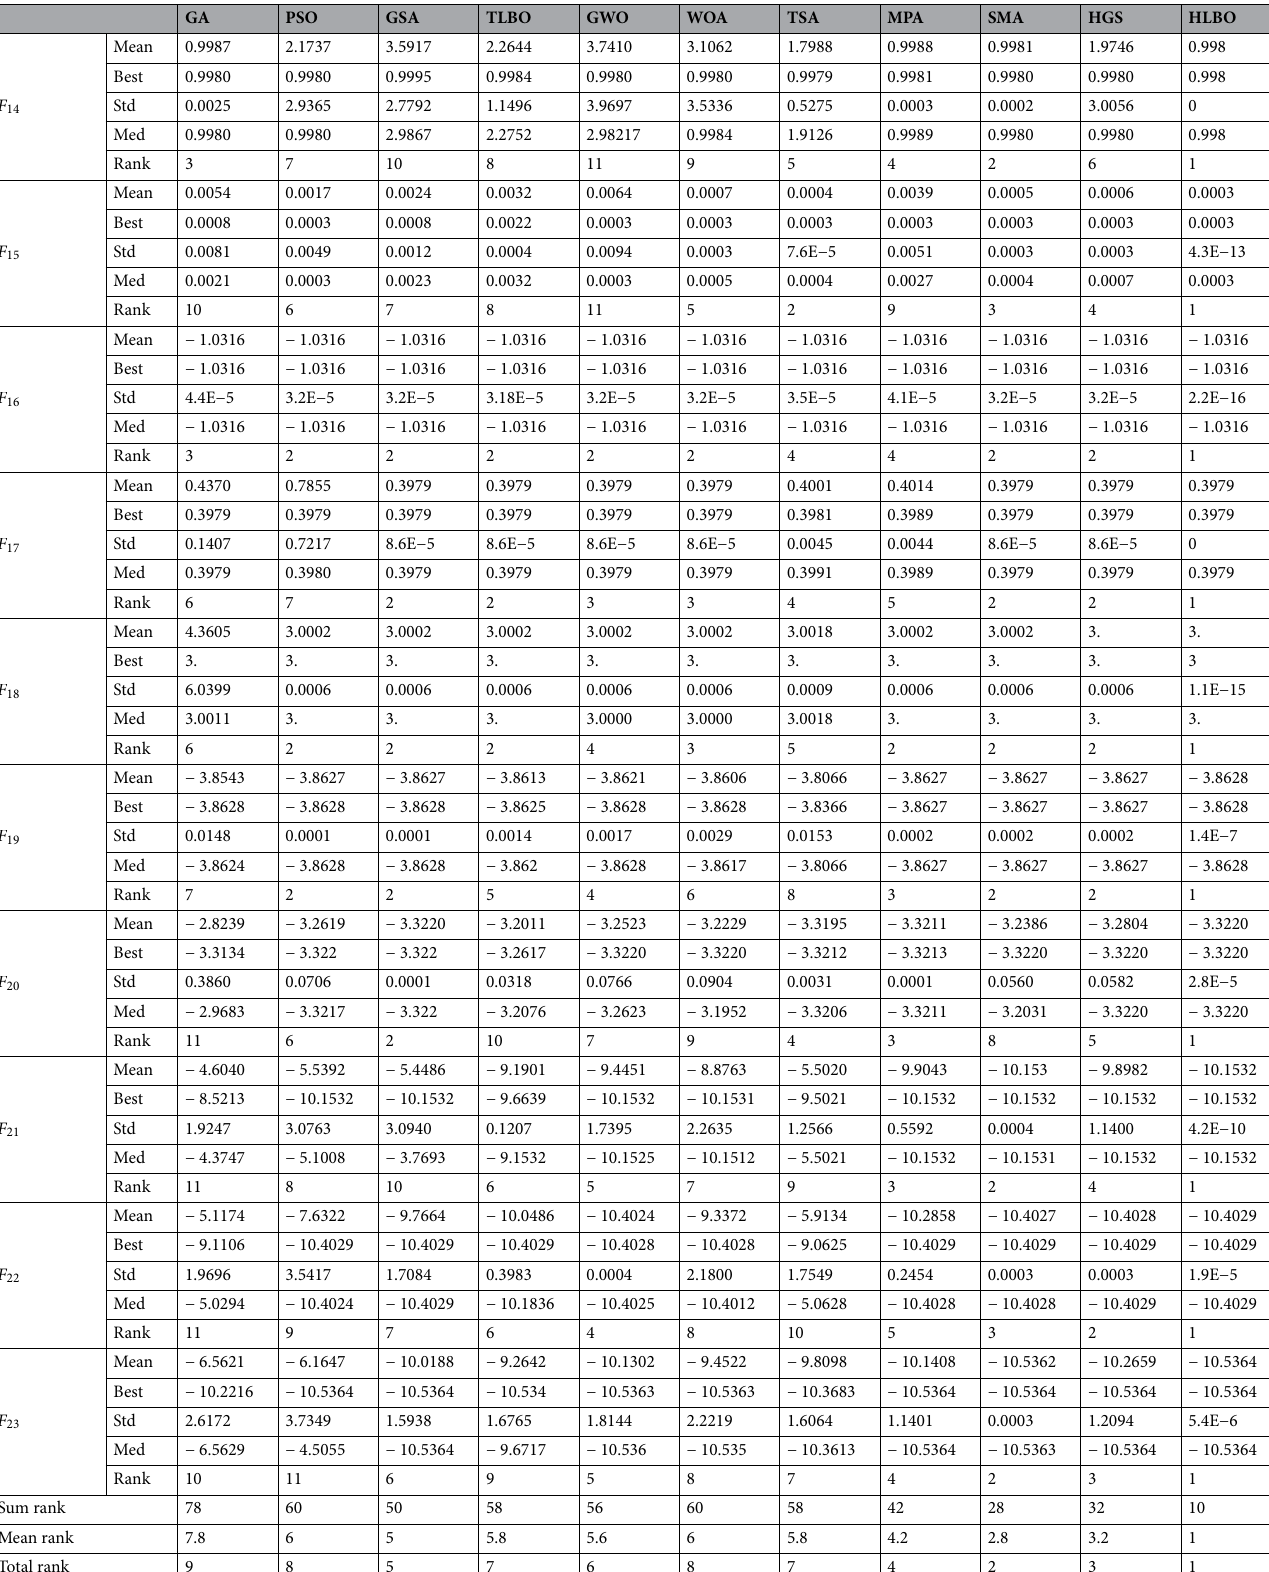
Table 4. Evaluation results of fixed-dimensional multimodal